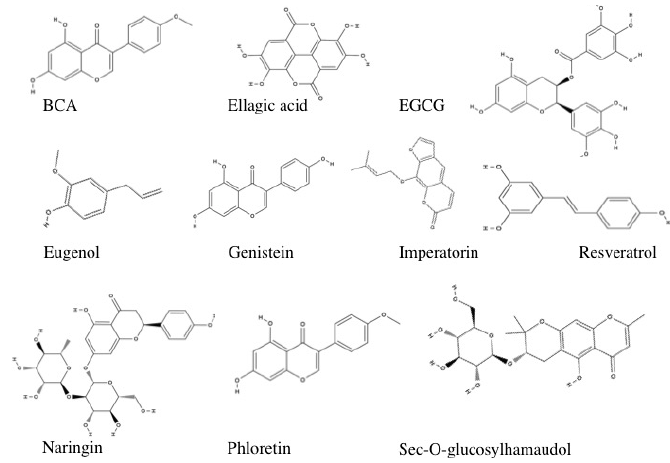
Figure 4 . Polyphenolic antioxidant structures. Figure 4. Polyphenolic antioxidant